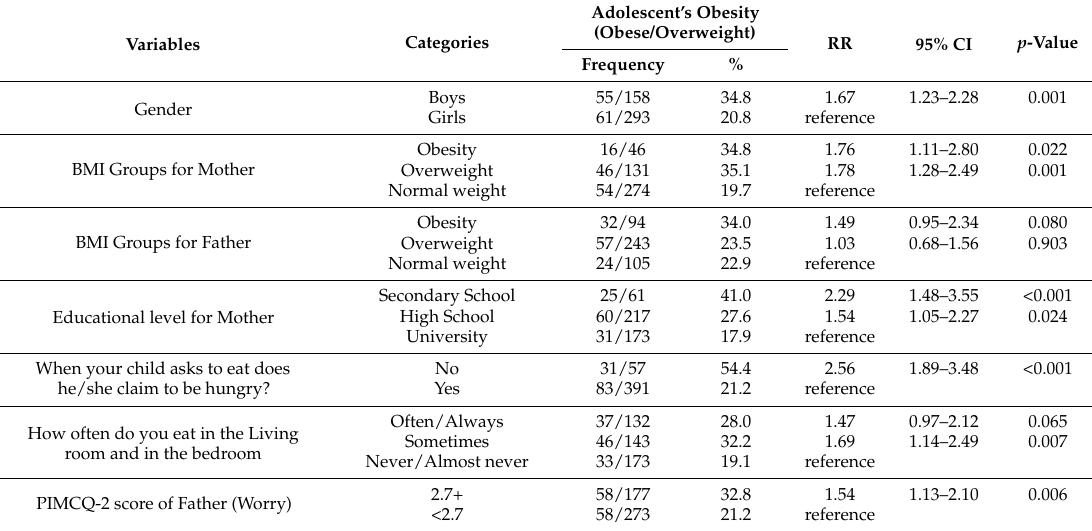
Table 3. Univariate analysis for adolescent’s obesity.